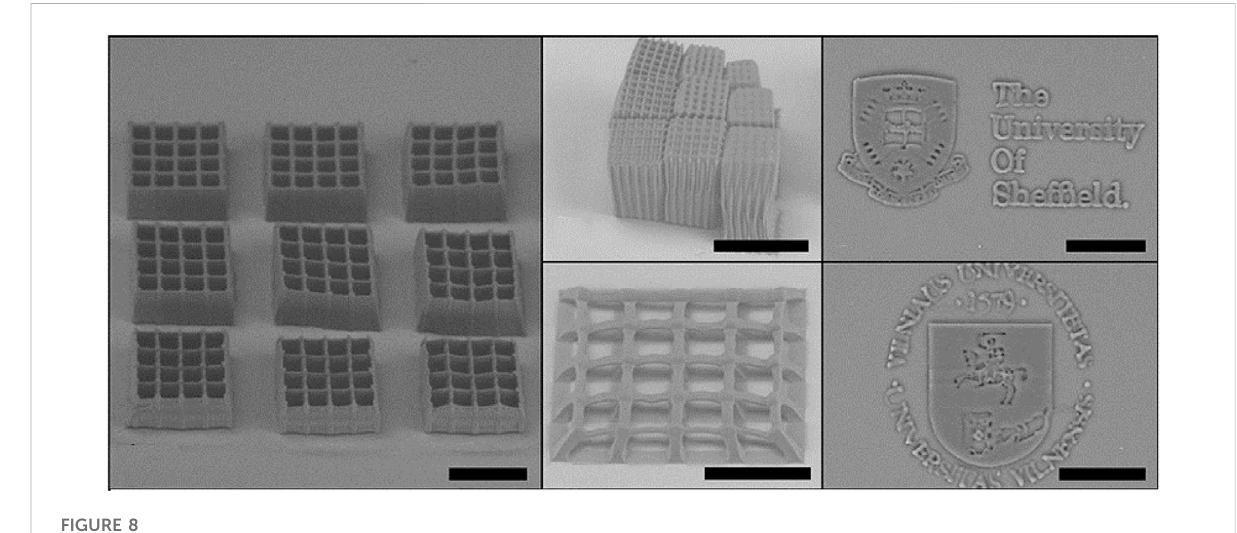
FIGURE 8 PGS-M 3D structures produced by DLW-2PP. Images collected and adapted from Pashneh-Tala et al.